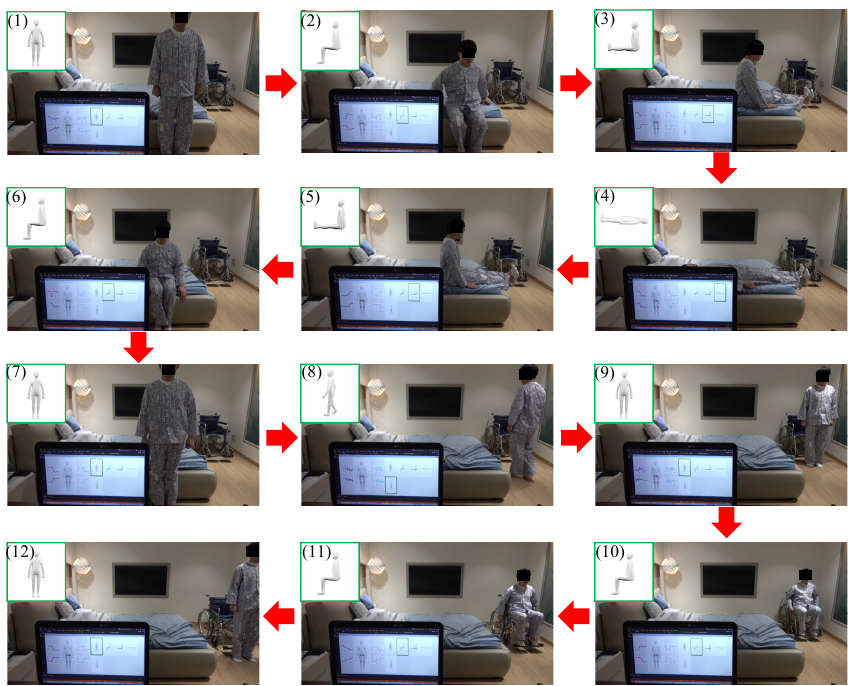
Figure 9. Test of the patient motion and posture monitoring system. ( 1 – 7 ) The patient lies down on the bed, and then stands up. ( 7 – 9 ) He moves to a wheelchair. ( 9 – 12 ) He sits on the wheelchair, moves via the wheelchair, and stands up from the wheelchair.